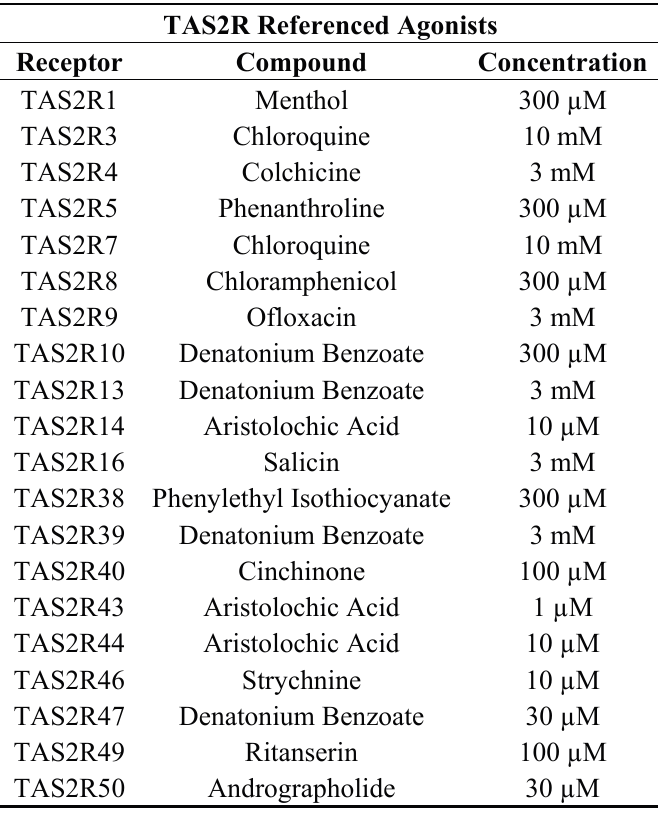
The reported concentrations are the highest used for each